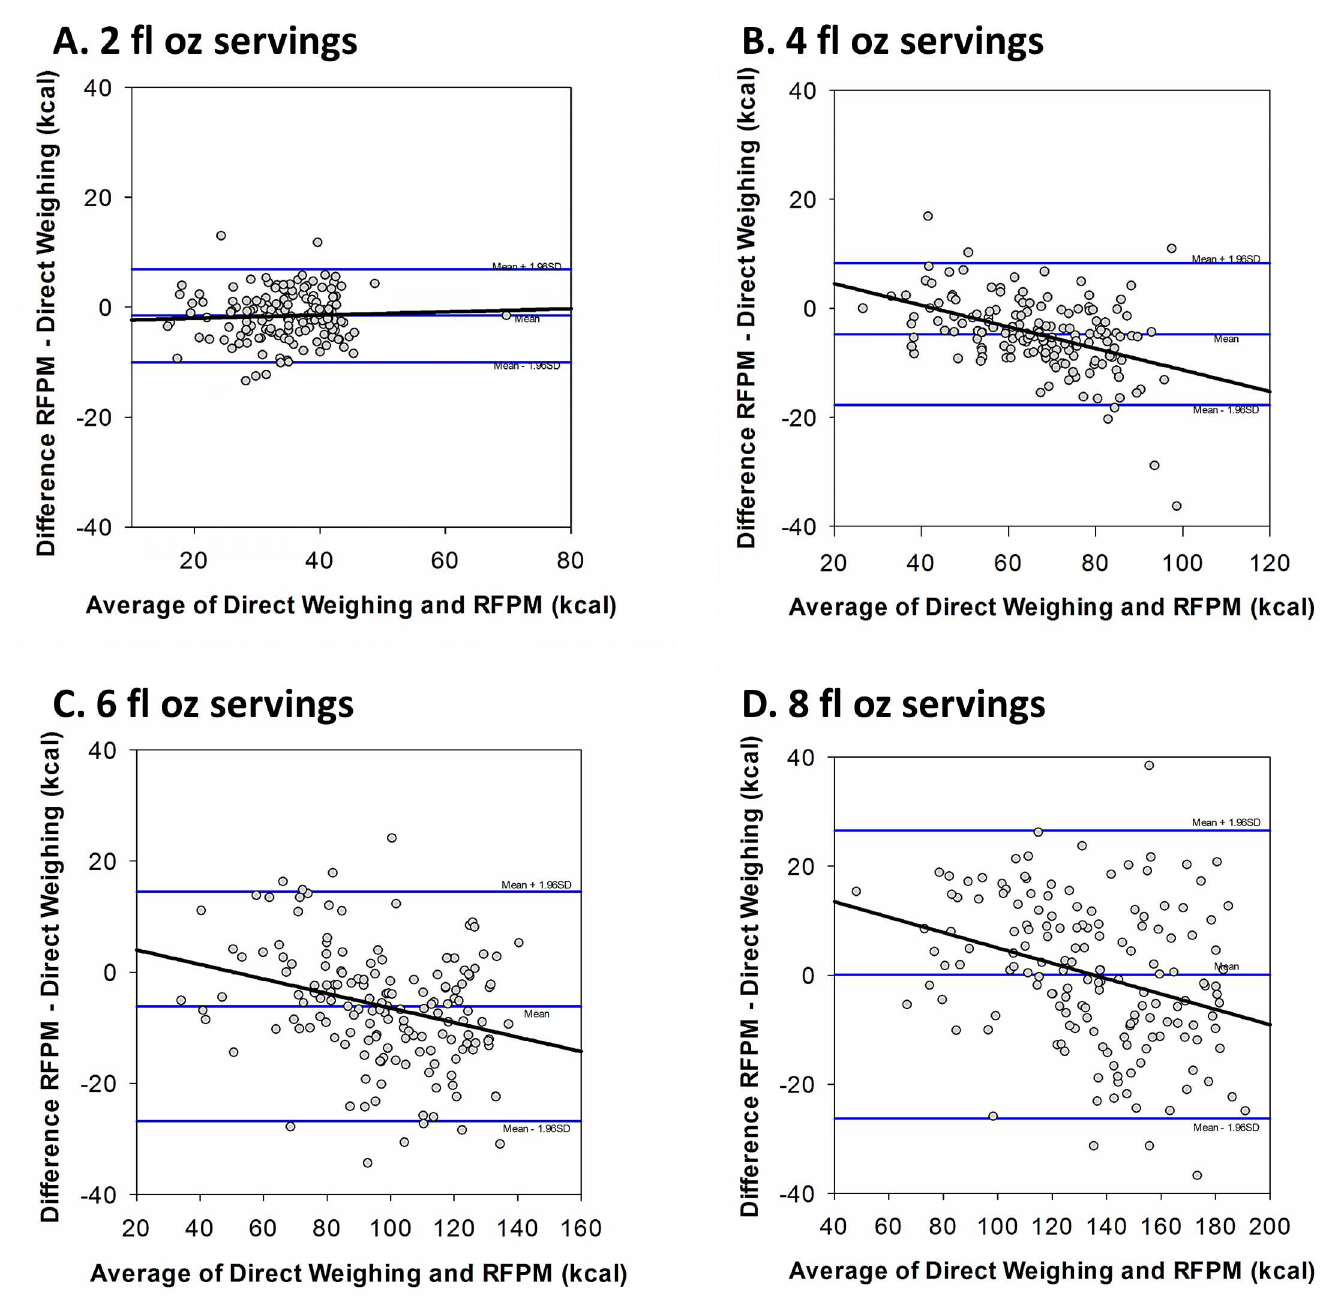
Fig 4. Bland-Altman analysis comparing energy measures of the RFPM and direct weighing in 2 fl oz, 4 fl oz, 6 fl oz, and 8 fl oz servings of infant